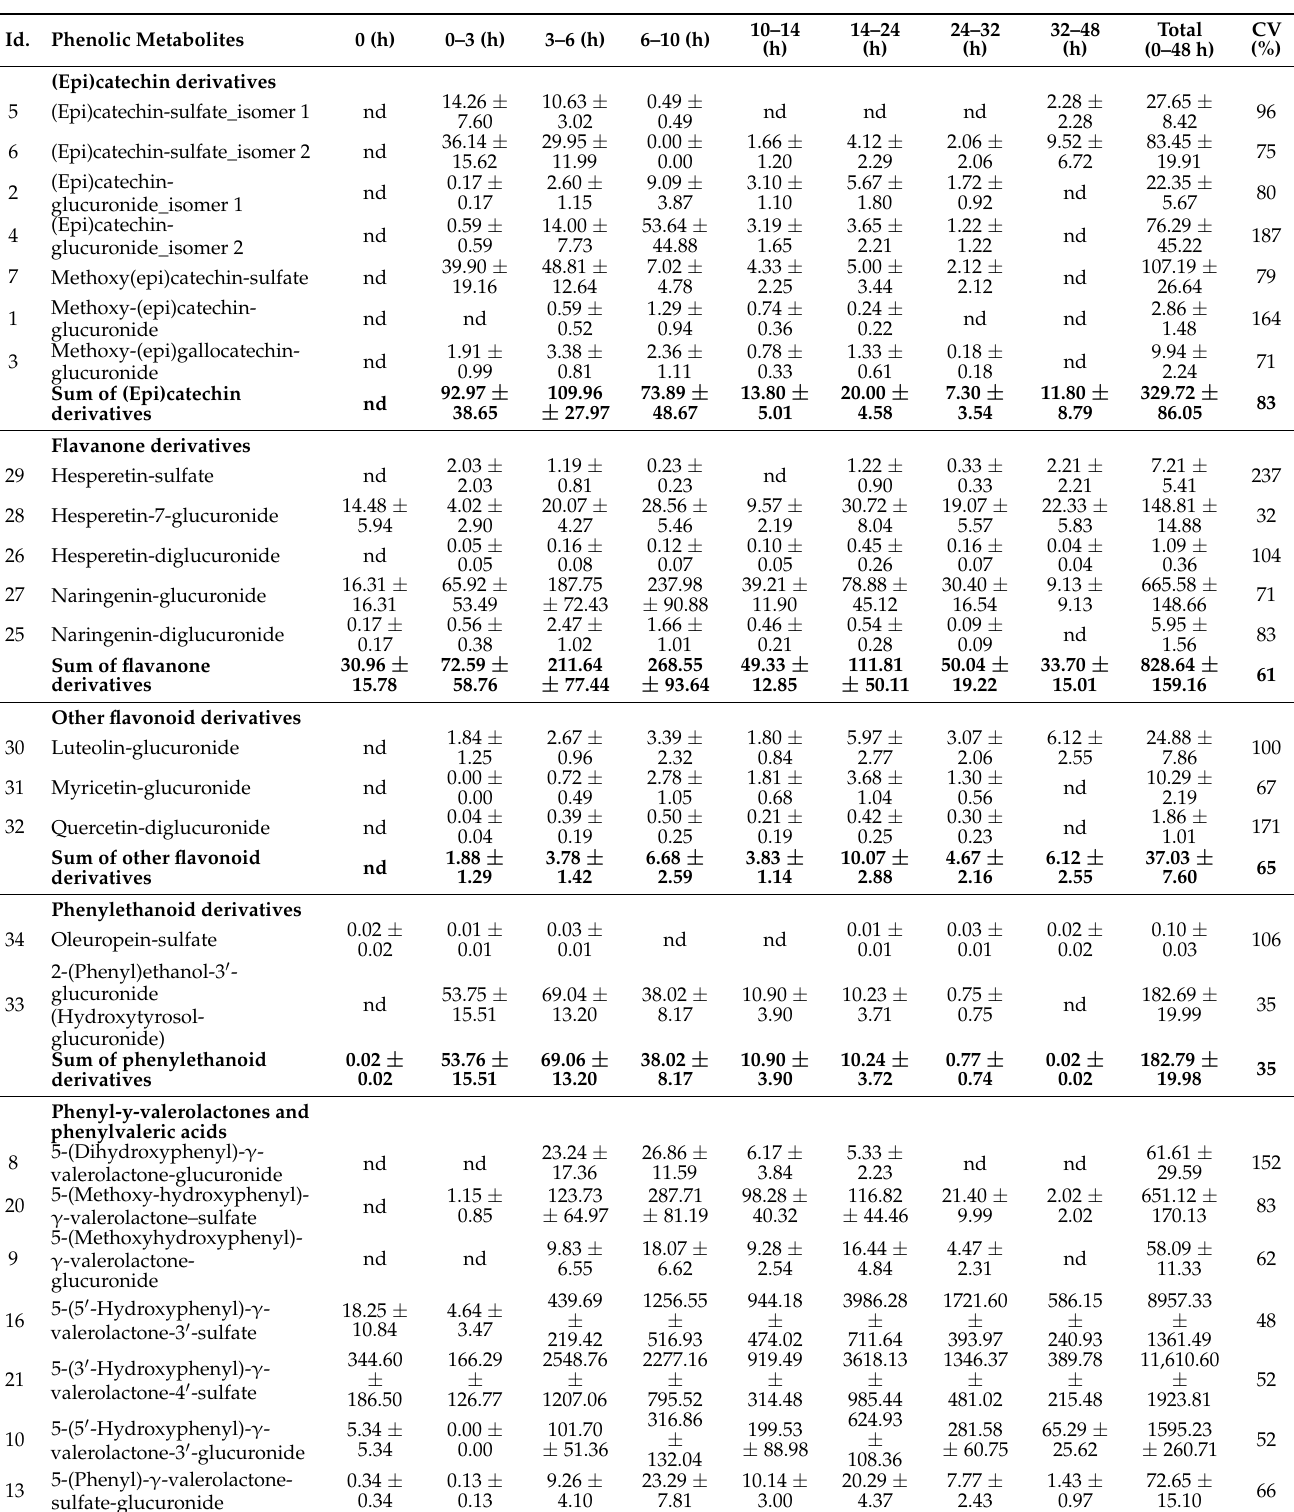
Table 5. Phenolic metabolites detected in urine of the supplemented volunteers ( n = 10). Values are expressed as µ g of compound, and data are reported as mean ± SEM. nd means not